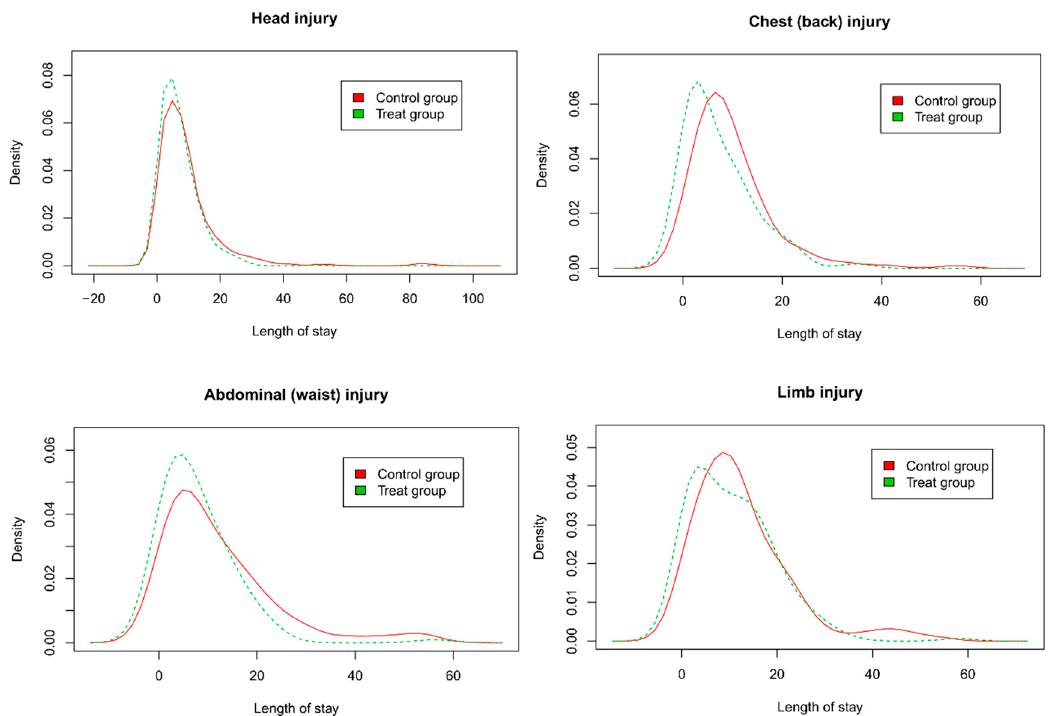
Figure 3. LoS of matched head injury, chest (back) injury, abdominal (waist), and limb injury patients transported by EMS.